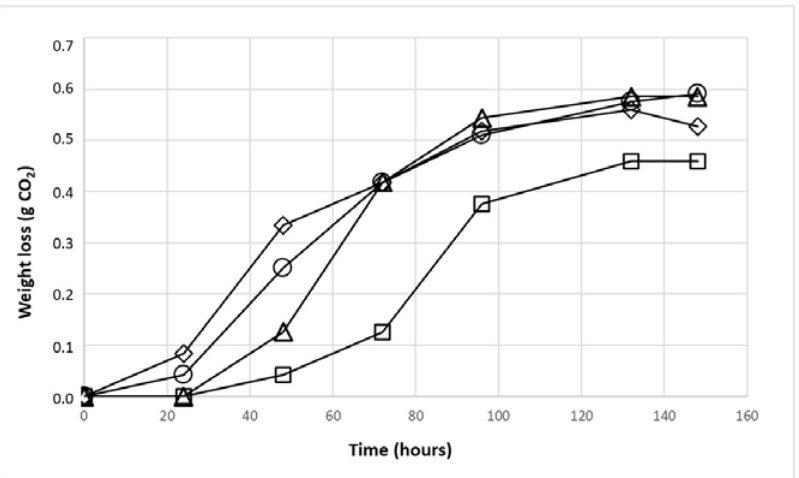
Figure 3. Fermentation kinetics (depicted as cumulative weight loss) of yeasts isolated from apricot fruits growing in malt wort + apricot puree (WPP). Circle: Pichia kudriavzevii L1; diamond: Hanseniaspora uvarum L2; triangle: H. pseudoguilliermondii L3; square: H. clermontiae L4. Data are means ± SD of three independent replicates. Where not visible, error bars lie below the symbols.